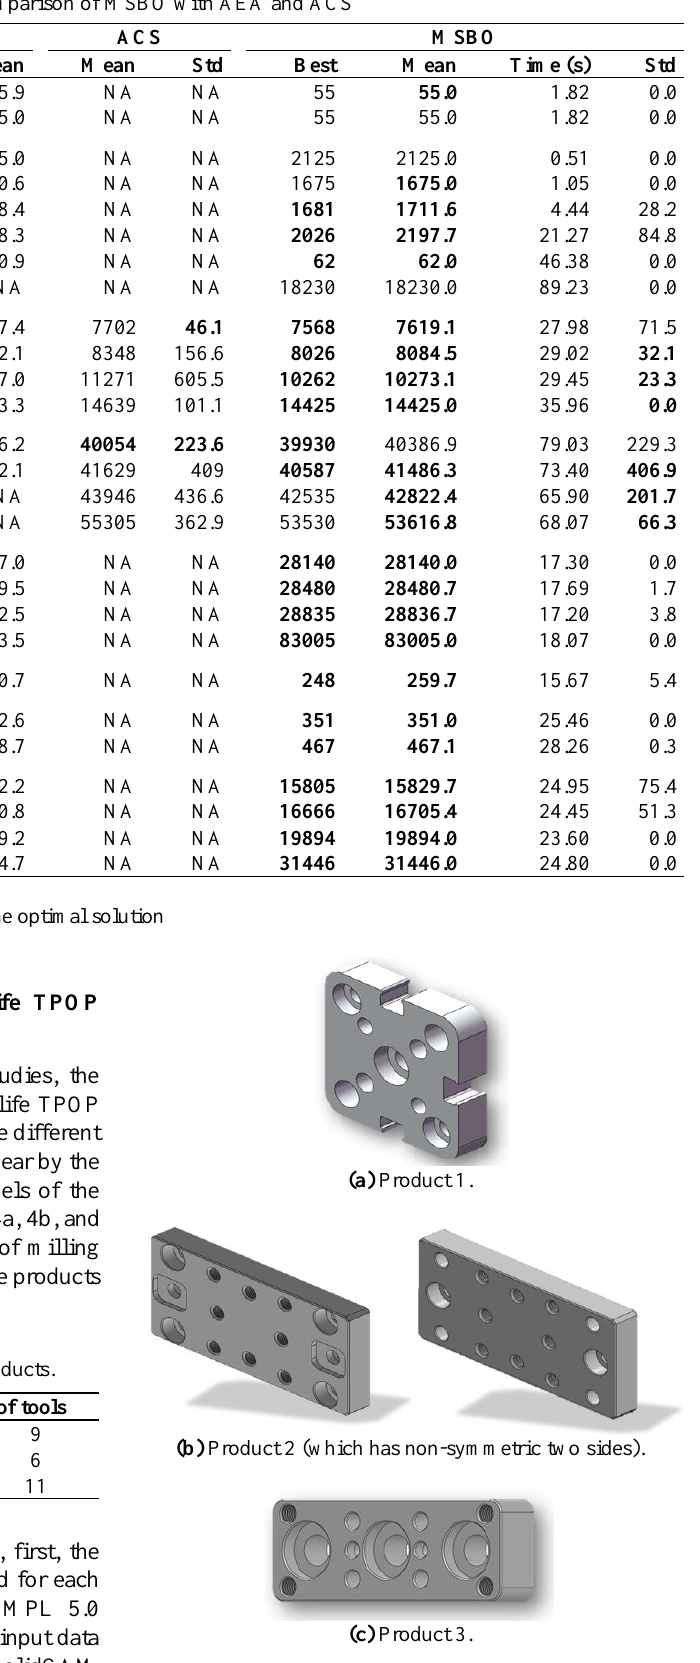
Figure 4. Solid models of the products considered for computational